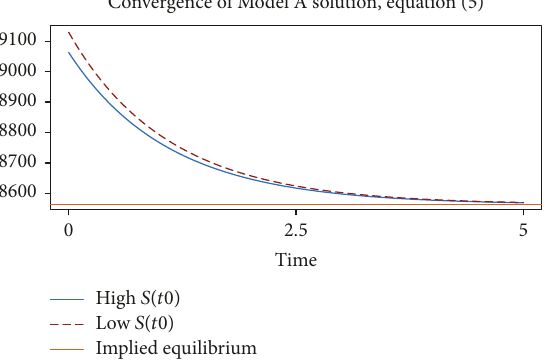
Figure 8: The convergence of the simulated theoretical stock prices by equation (6) (implied equilibrium = 8563.101; high stock index initial value S ( 𝑡 0 ) = 9063.101; low stock index initial value S ( 𝑡 0 ) = 8063.101).